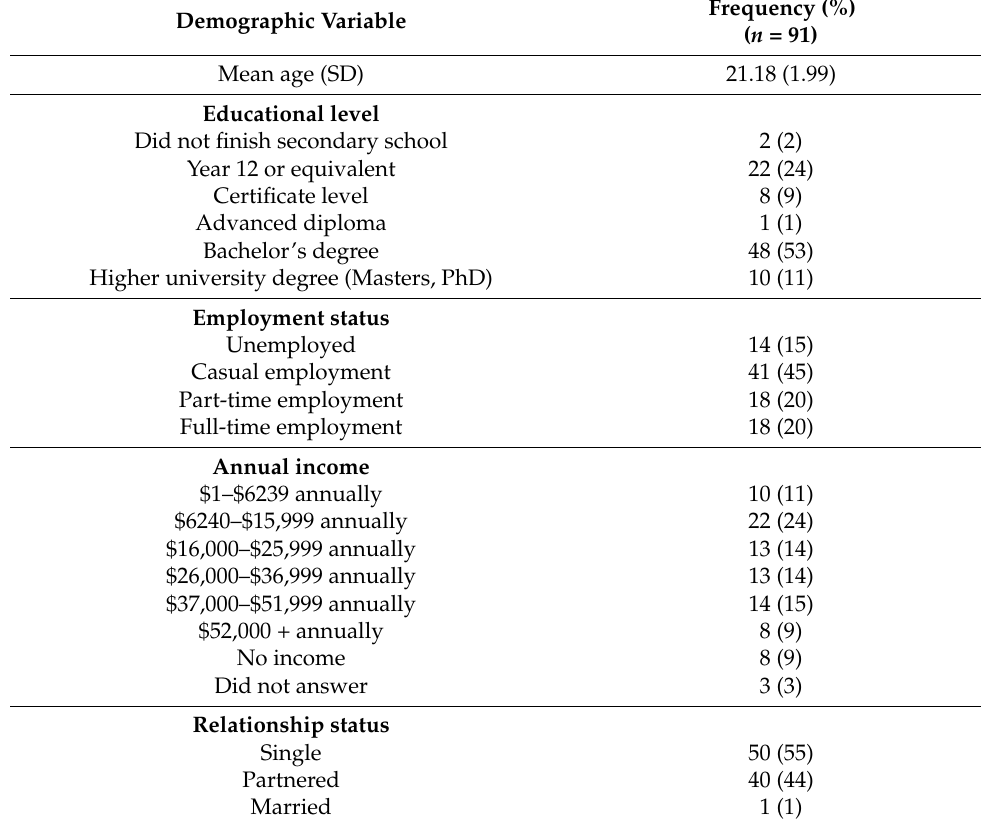
Table 1. Demographic